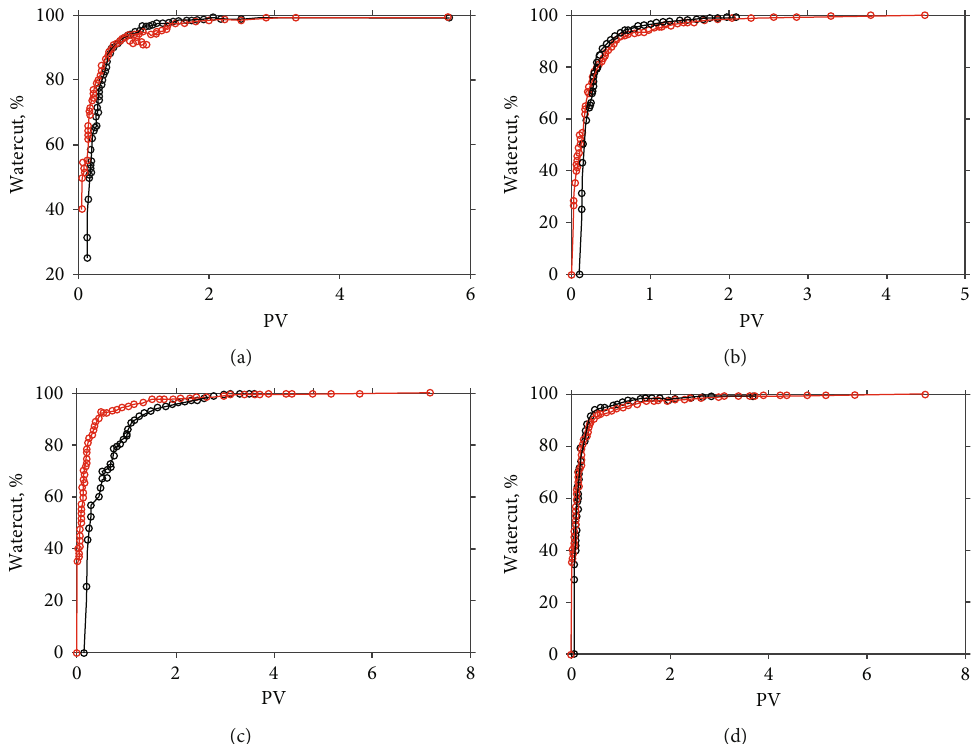
Figure 9: Relationship between water content and injection pore volume before and after the construction of fracture in the experimental core. The red and black points represent the results before and after the construction of fracture. (a) Cores H1-5. (b) Cores H11. (c) Cores H13. (d) Cores H2-12. Table 2: Displacement indices of water-free displacement before and after the construction of fractures. Flooding characteristics at water-free displacement